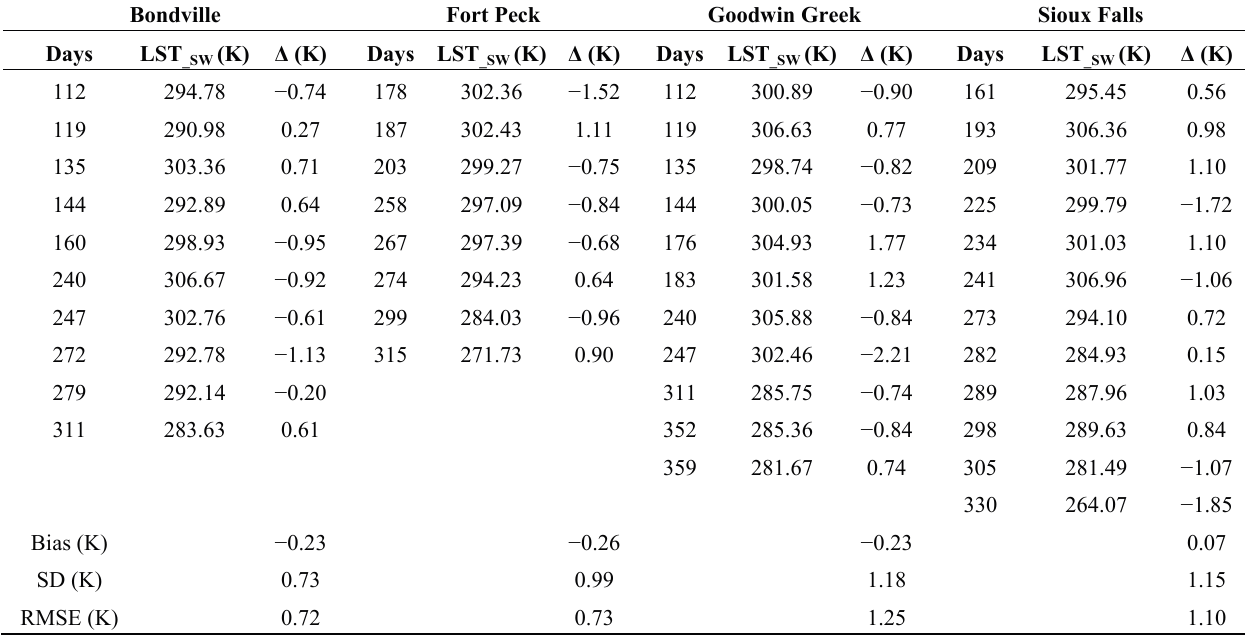
) using a split window (SW) algorithm from TIRS and the _SW and LST for four selected _SW _g